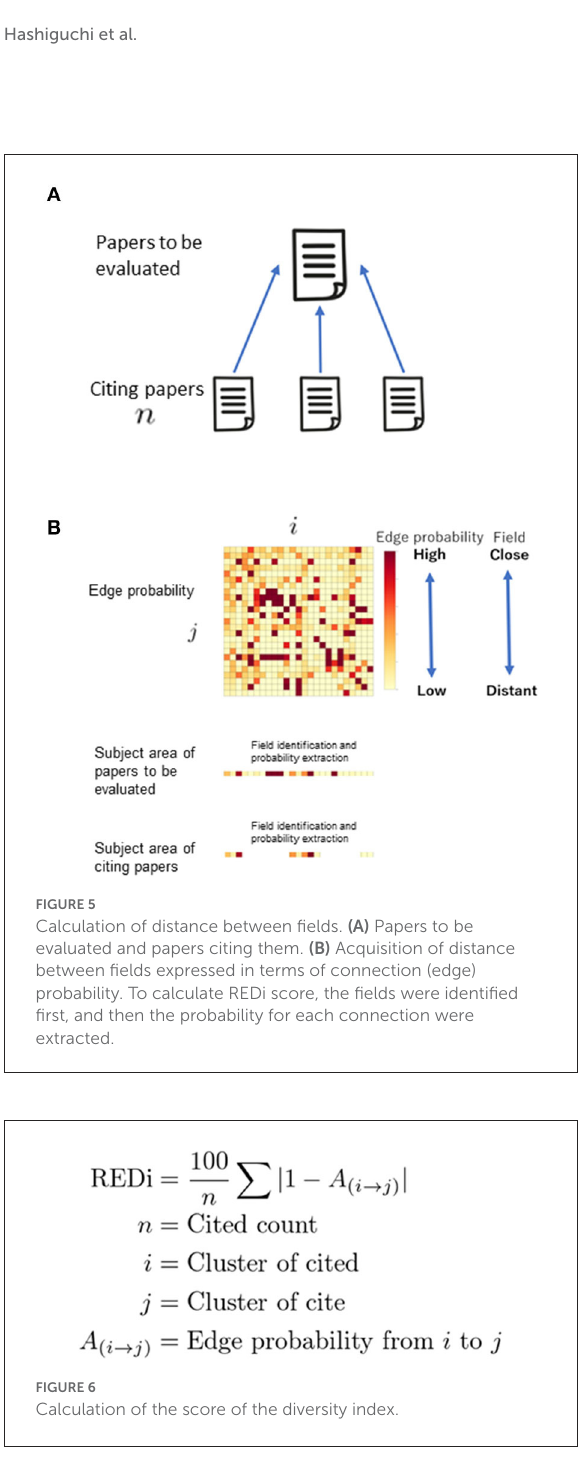
This probability matrix is used to calculate REDi score according to the following procedure. (1) Identification of the fields to which the papers to be evaluated and the papers that cite those papers belong among the predefined 25 fields (Figure 5A). (2) Calculation of the score using the connection (edge) probability (Figure